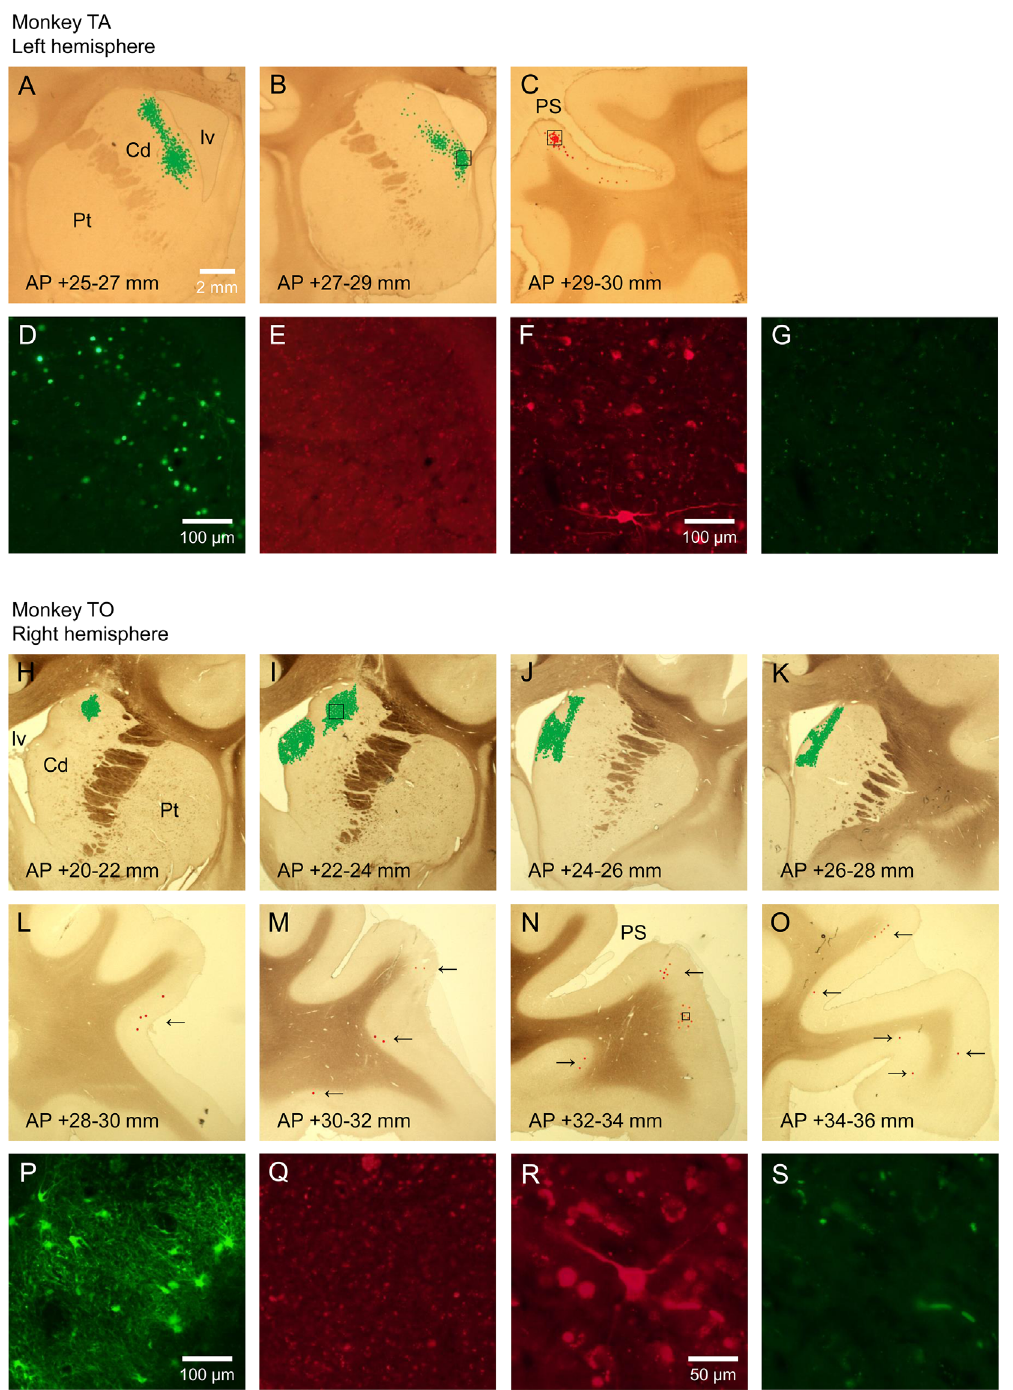
Fig 4. mCherry and eGFP expressions in the departure and the destination areas of the frontostriatal pathways. (A-C). Distribution of mCherry- and eGFP-positive cells in the left Cd and the ipsilateral LPFC of Monkey TA. Red dots represent mCherry-positive cells and green dots represent eGFP-positive cells. mCherry- and eGFP-positive cells were aggregated from several slides across ~2 mm along the AP direction and then superimposed on a corresponding wide-area photomicrograph. (D). eGFP-expressing cells in the boxed area of figure B as observed with a NIBA filter cube. (E). The micrograph of the same area as (D) as observed with a WIG filter cube. (F). mCherry-expressing cells in the boxed area of figure C as observed with a WIG filter cube. (G). The micrograph of the same area as (F) as observed with a NIBA filter cube. (H-O). Distribution of mCherry- and eGFP-positive cells in the right Cd and the ipsilateral LPFC of Monkey TO. Black arrows indicate where mCherry-expressing cells are. (P). eGFP-expressing cells in the boxed area of figure I as observed with a NIBA filter cube. (Q). The micrograph of the same area as (P) as observed with a WIG filter cube. (R). A mCherry-expressing cell in the